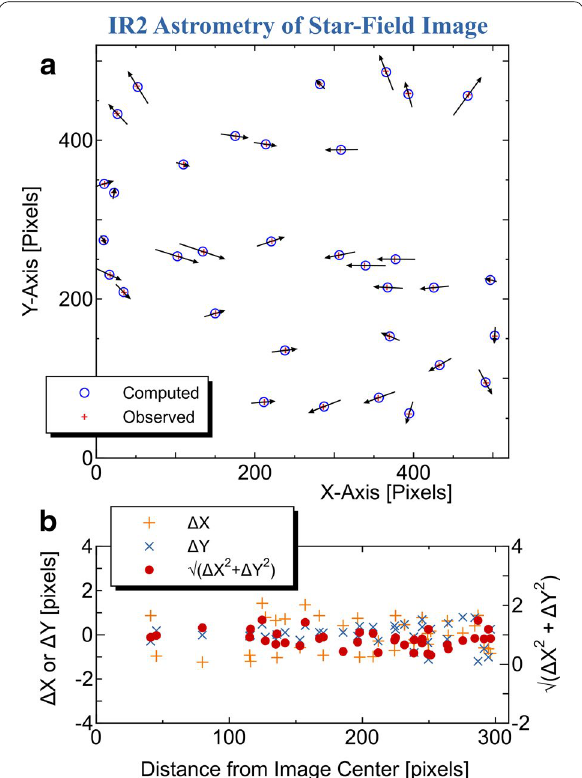
Fig. 9 Examination of geometrical distortion in IR2 images. a Residual vectors plotted in the star‑field image on which astrom‑ etry was performed. The vectors are magnified by a factor of 40. b Systematic behavior of residuals examined by plotting them against distances from the image center. Since the geometrical distortion of the optics origin is expected to be the point symmetry relative to the image center, this plot suggests that the distortion in the IR2 image is negligible